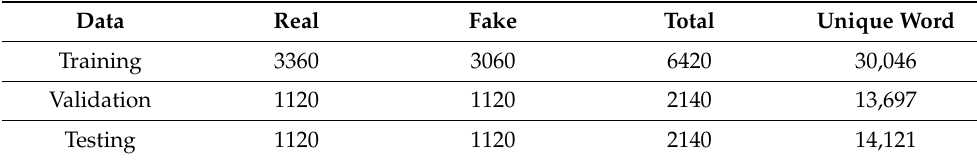
Table 1. Data distribution of a dataset.